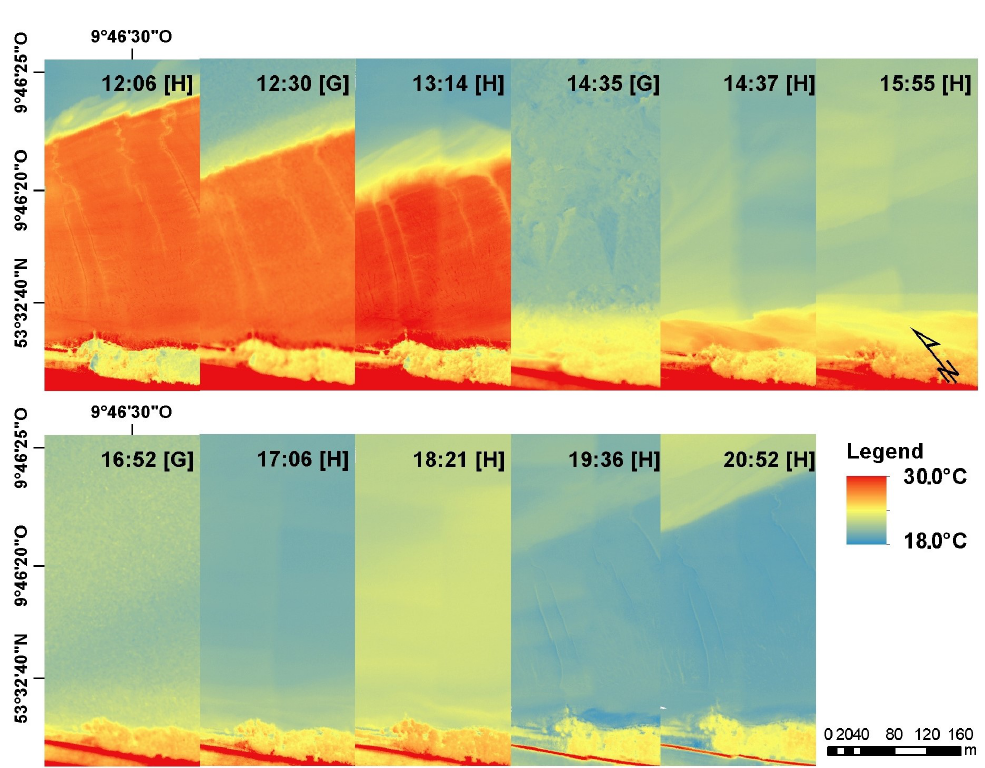
Figure 11. Part of the intertidal mudflats in the hexacopter survey area as a sequence of mosaics from gyrocopter [G] and hexacopter [H] data on 1 July 2015, arranged according to acquisition